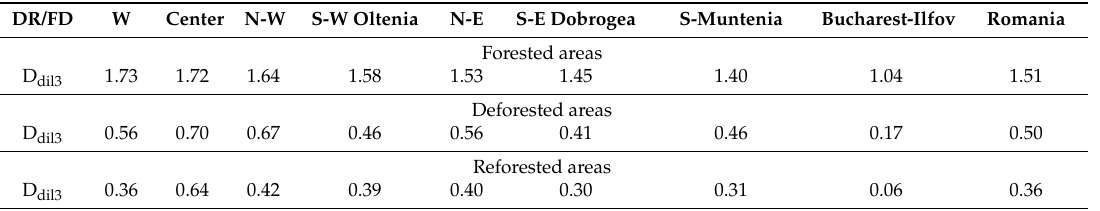
Table 4. Fractal dimension of forested, deforested and reforested areas (D dil3 ) from development regions of Romania between 2000 and 2012.